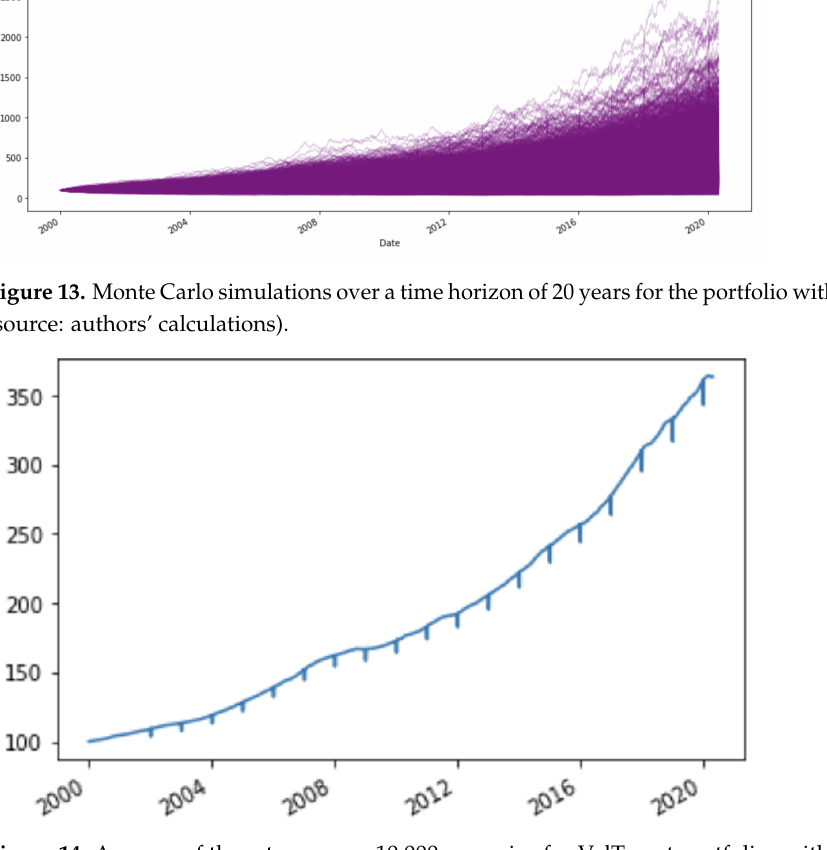
Figure 14. Average of the returns over 10,000 scenarios for VolTarget portfolios with ML volatility (source: authors’ calculations).